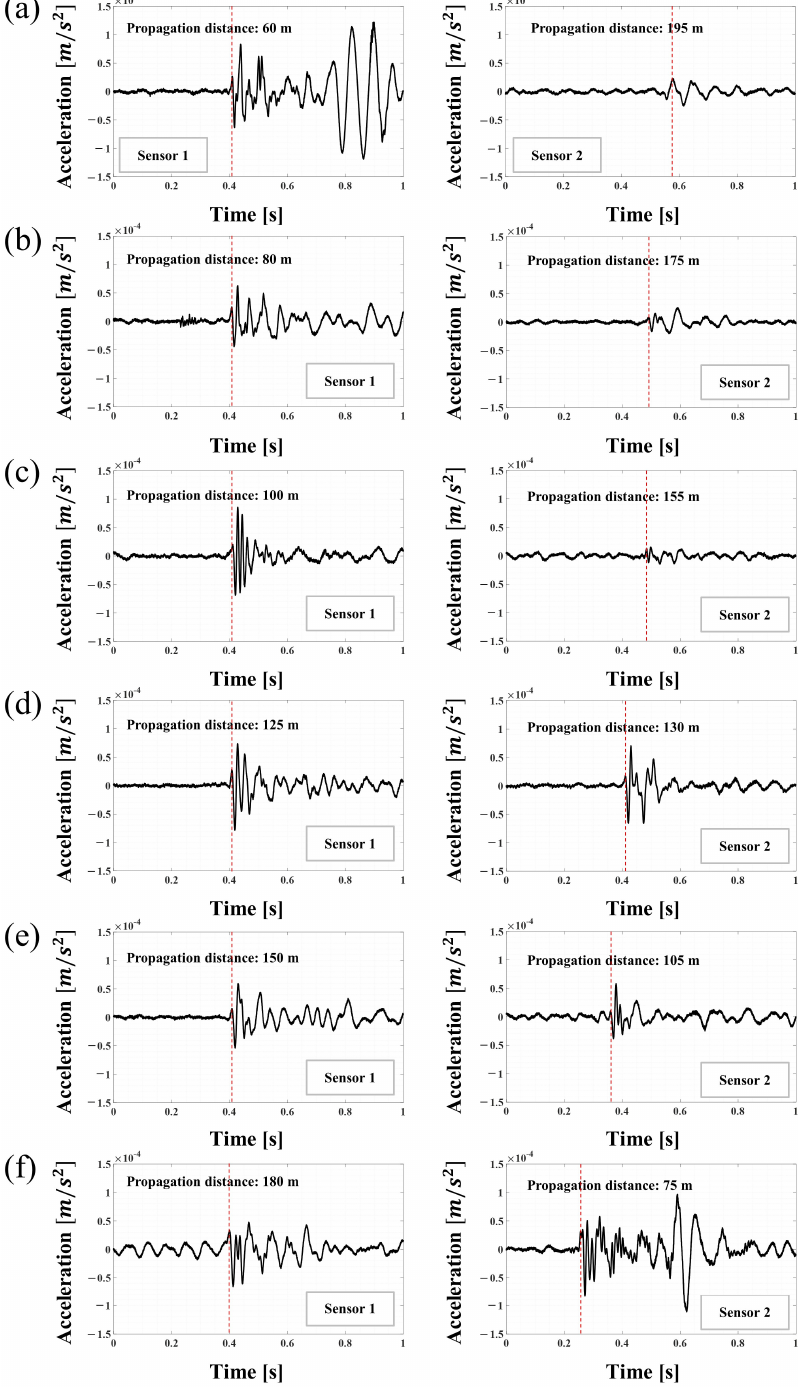
Figure 20. Excavation signals obtained at various points: ( a ) results of the excavation test at 60 m, ( b ) results of the excavation test at 80 m, ( c ) results of the excavation test at 100 m, ( d ) results of the excavation test at 120 m, ( e ) results of the excavation test at 150 m, and ( f ) results of the excavation test at 180